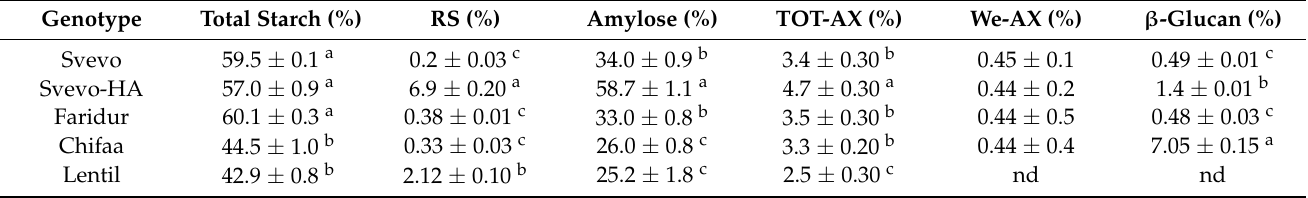
Table 1. Composition of Svevo, Svevo-HA, Faridur, Chifaa and the elite lentil line 6002/ILWL118/1-1 whole-flours for total starch, resistant starch (RS), amylose, total arabinoxylans (TOT-AX), water extractable arabinoxylans (WE-AX) and β -glucan. Non-detected, nd; a–c different letters within each column show significant differences ( p <